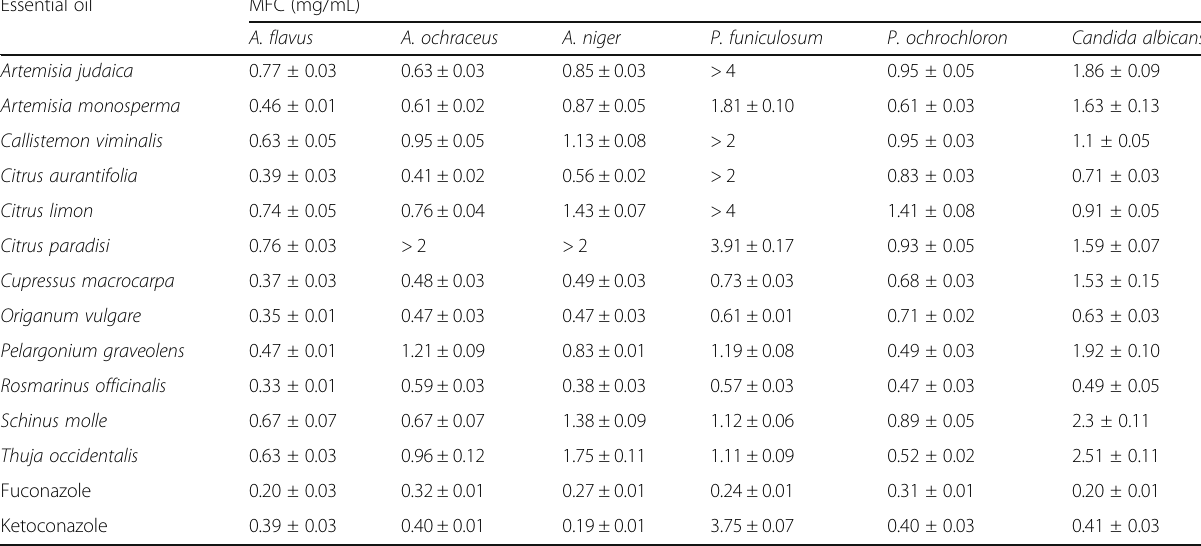
Table 4 Minimum fungicidal concentration (MFC) of essential oils on fungal strains Essential oil